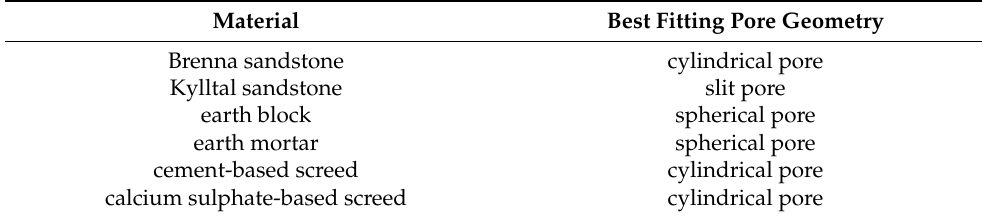
Table 4. Chosen pore geometry for the pore network of the six material